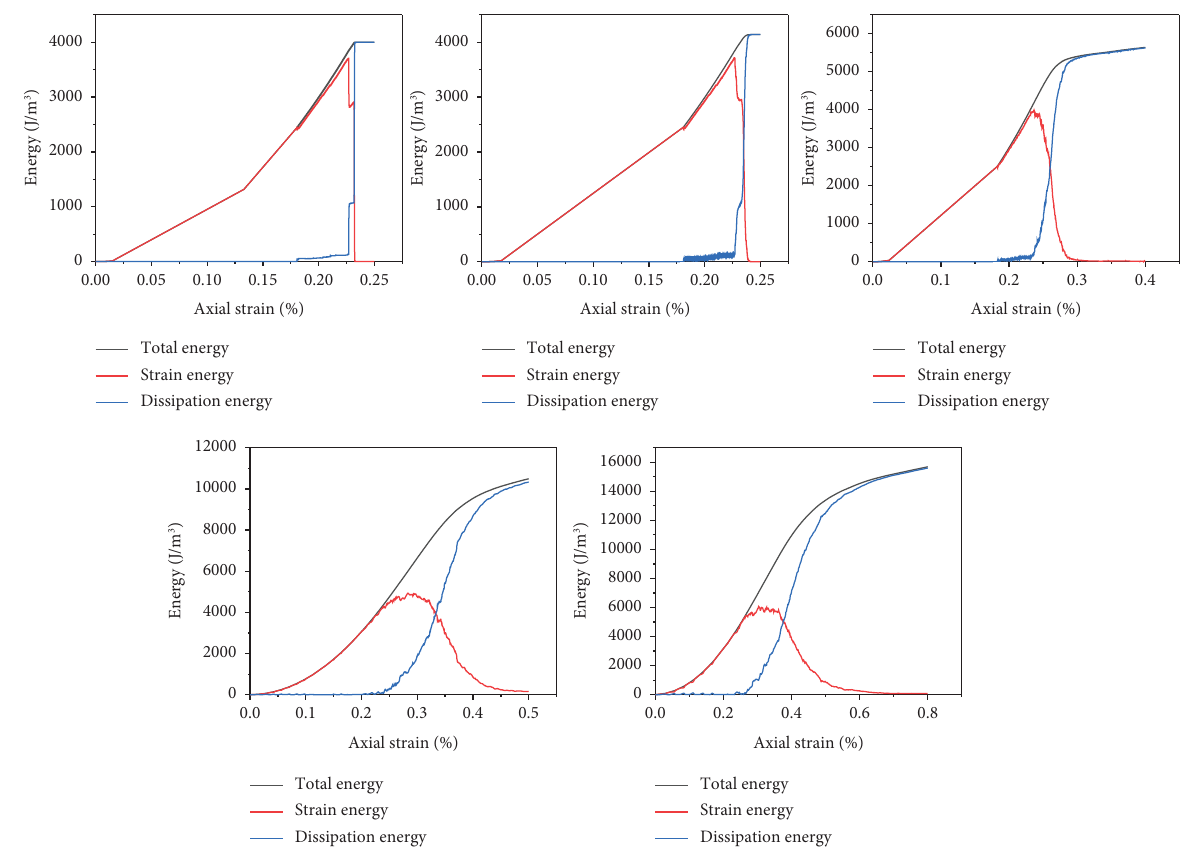
Figure 12: Schematic of energy evolution at diferent loading rates.